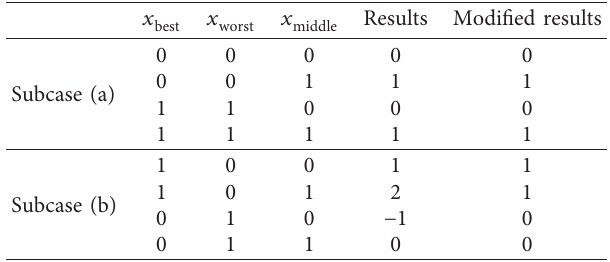
Table 8: Results of binary senior gaining and sharing stage of Case 1 with k f � 1.